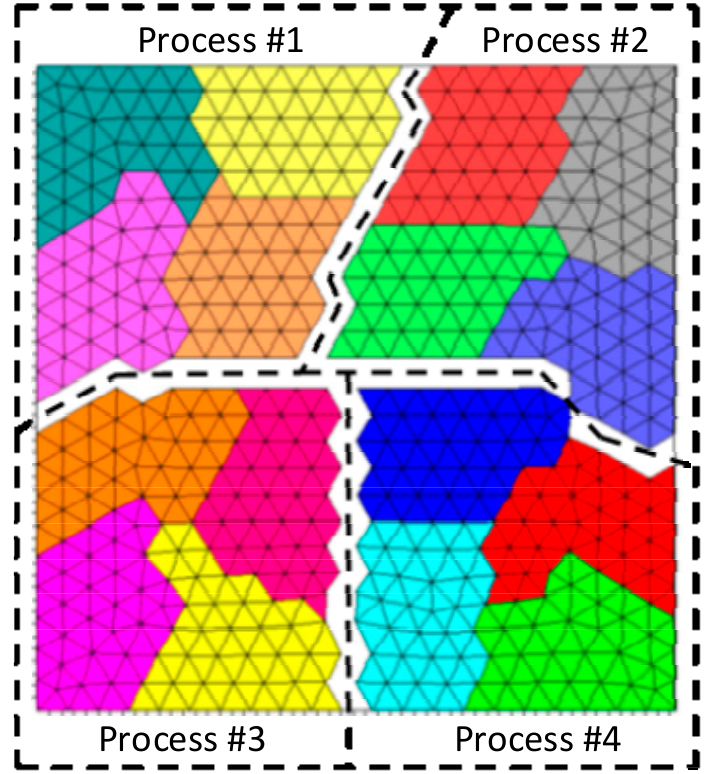
Figure 1. Nested mesh hierarchy model. The proposed multi-level parallel scheme of Algorithm 1 is presented in Figure